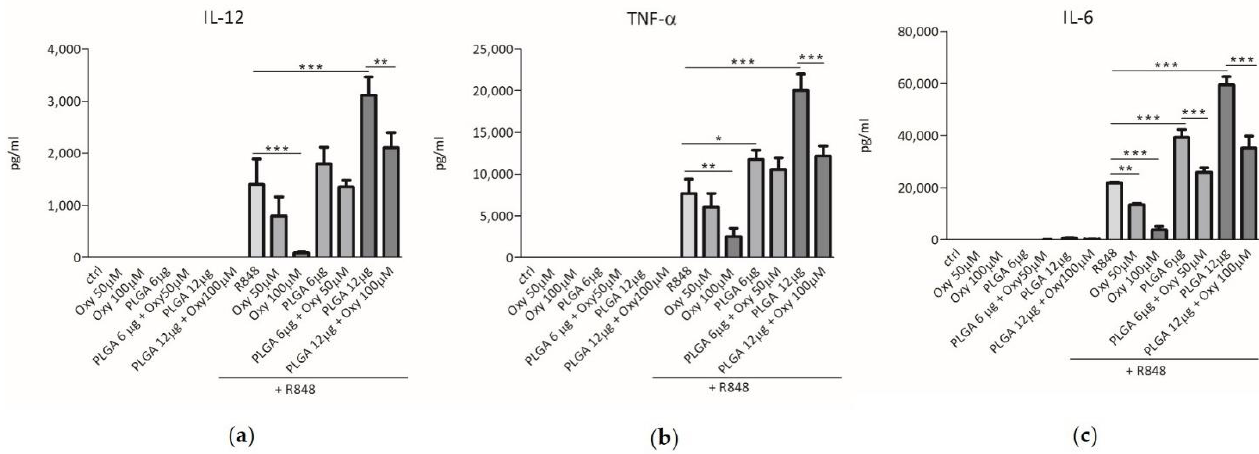
Figure 3. Effects of free or PLGA-conjugated oxyresveratrol on pro-inflammatory cytokine release by human dendritic cells (DCs). DCs were treated for 24 h with the indicated doses of free oxyresveratrol (Oxy), bare PLGA nanoparticles (PLGA) or oxyresveratrol-bearing PLGA nanoparticles (PLGA + Oxy). All the treatments were conducted in the absence or presence of 5 μM R848. The release of IL-12 ( a ), TNF-α ( b ) and IL-6 ( c ) in culture supernatants was evaluated by ELISA assay. The results are expressed as the mean value ±SD of four independent experiments. * p < 0.05, ** p < 0.01 *** p < 0.001 by two-way ANOVA followed by Bonferroni post-test.